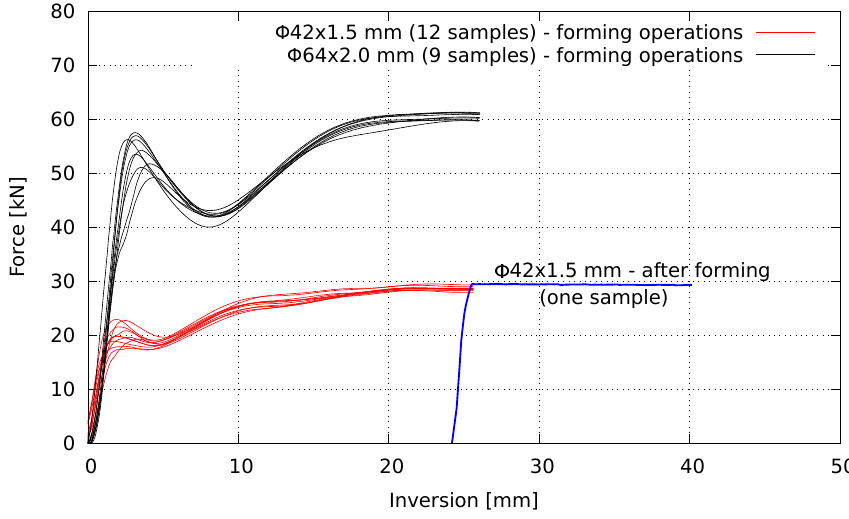
Figure 6. Force-shortening curves of the core